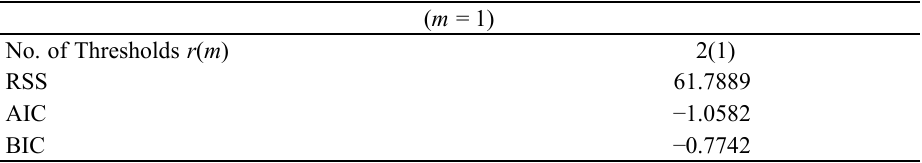
Table 6. Determination of the number of regimes for medium-sized banks